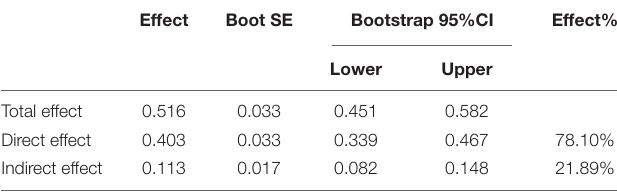
TABLE 4 | Resilience in the mediation effect analysis ( N = 476).